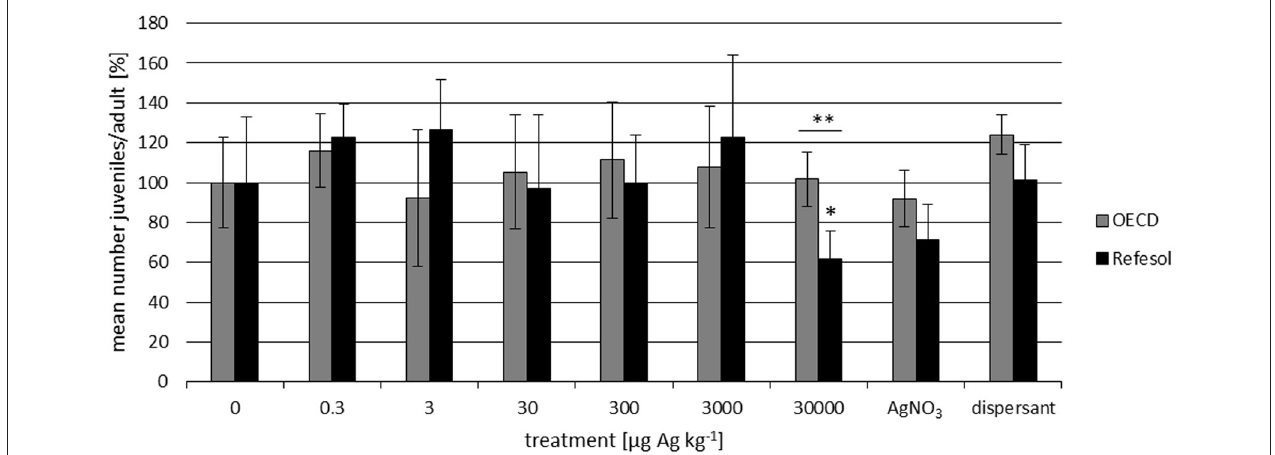
FIGURE 1 | Number of F. candida juveniles per adult normalized to the control (mean ± SD) after a 28-day reproduction test in OECD soil and RefeSol. The nominal concentrations refer to NM-300K in µ g Ag kg − 1 and the AgNO 3 treatment contained the same amount of silver as the 30,000 µ g Ag kg − 1 NM-300K treatment. The dispersant control contained the same amount of dispersant as the highest NM-300K treatment. Statistically significant difference between the two soils: ** p ≤ 0.01. Significant difference between the treatment and the respective control: * p ≤ 0.05.